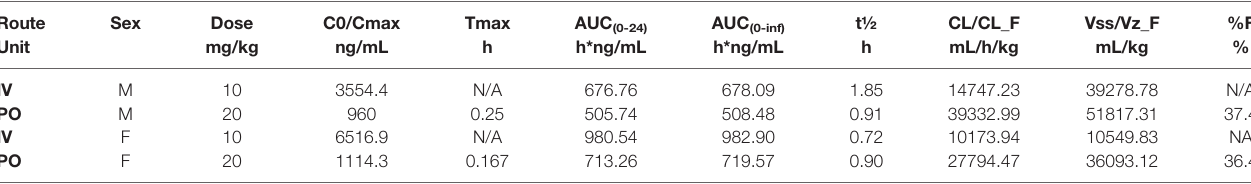
TABLE 2 | Tofacitinib pharmacokinetic parameters in plasma following IV and PO administration.